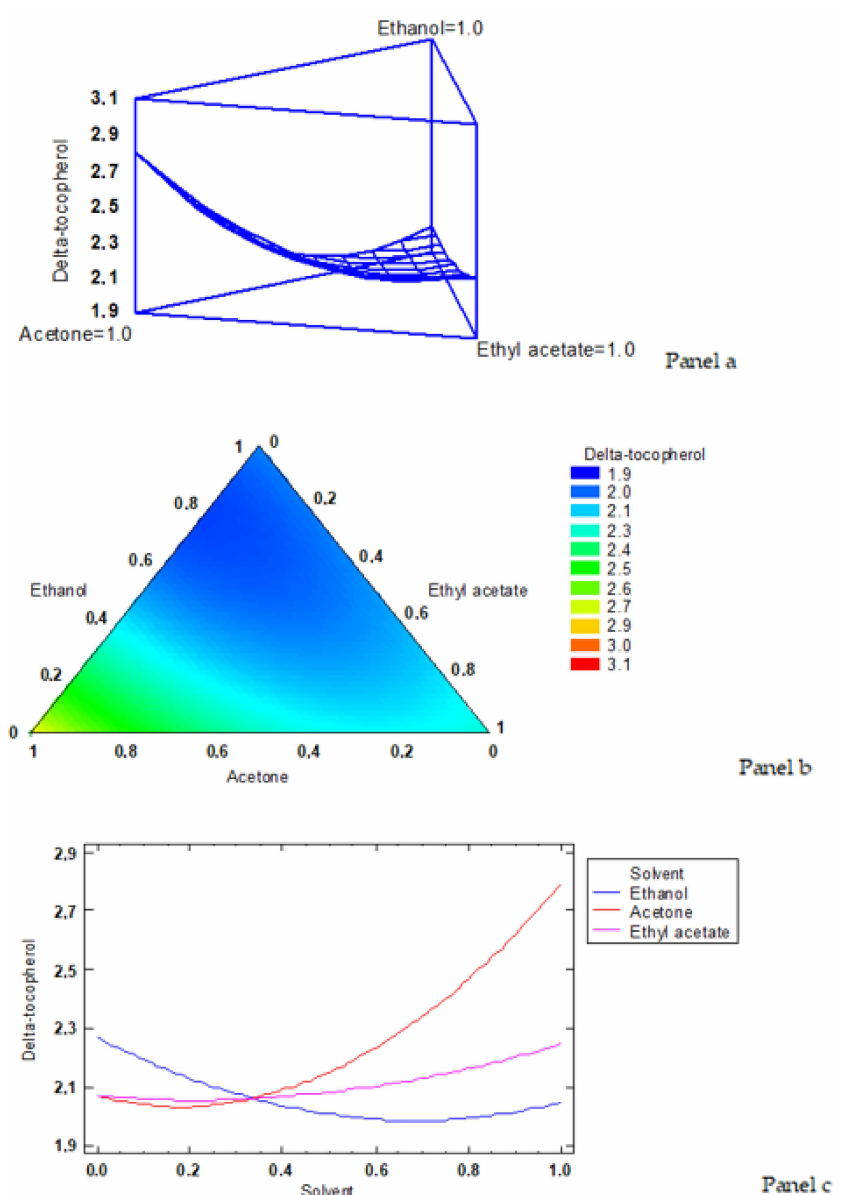
Figure 4. Application of the simplex-lattice design on the fitting model corresponding to the δ -tocopherol content (mg · kg − 1 lipids). Panel a : estimated response surface; Panel b : contours of estimated response surface; Panel c : trace plot for δ -tocopherol